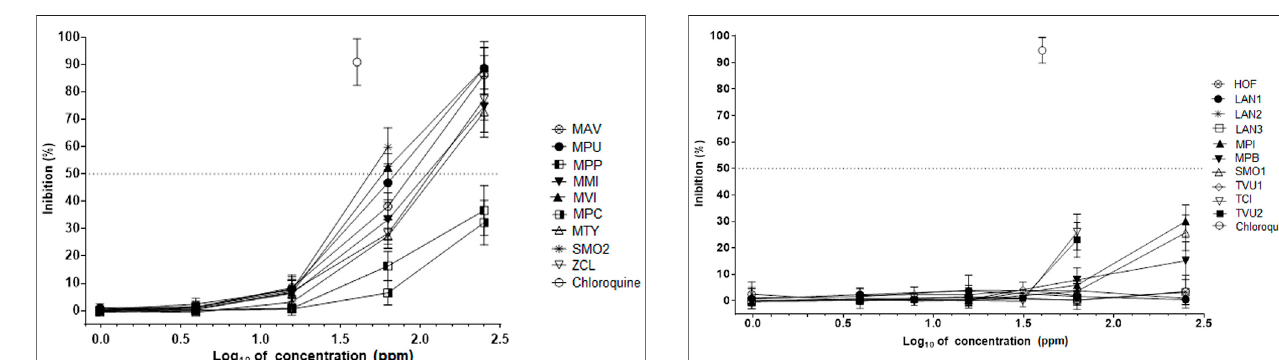
FIGURE 5 | Inhibition of SARS-CoV-2 by essential oils. MAV — Mentha aquatica “ Veronica ” ; MPU — Mentha pulegium ; MPP — Mentha x piperita “ Perpeta ” ; MMI — Mentha microphylla ; MVI — Mentha vilosa ; MPC — Mentha x piperita “ Citrata ” ; SMO2 — Satureja montana ; MTY — Micromeria thymifolia ; ZCL — Ziziphora clinopodioid es. The inhibition rates of SARS-CoV- 2 of essential oils in infected Vero 76 cells were determined in 72 h incubation assays.Chloroquinewasused asareferenceantiviralcompound. Datapoints represent the means (±SD) of three independent biological replicates with three technical replicates.